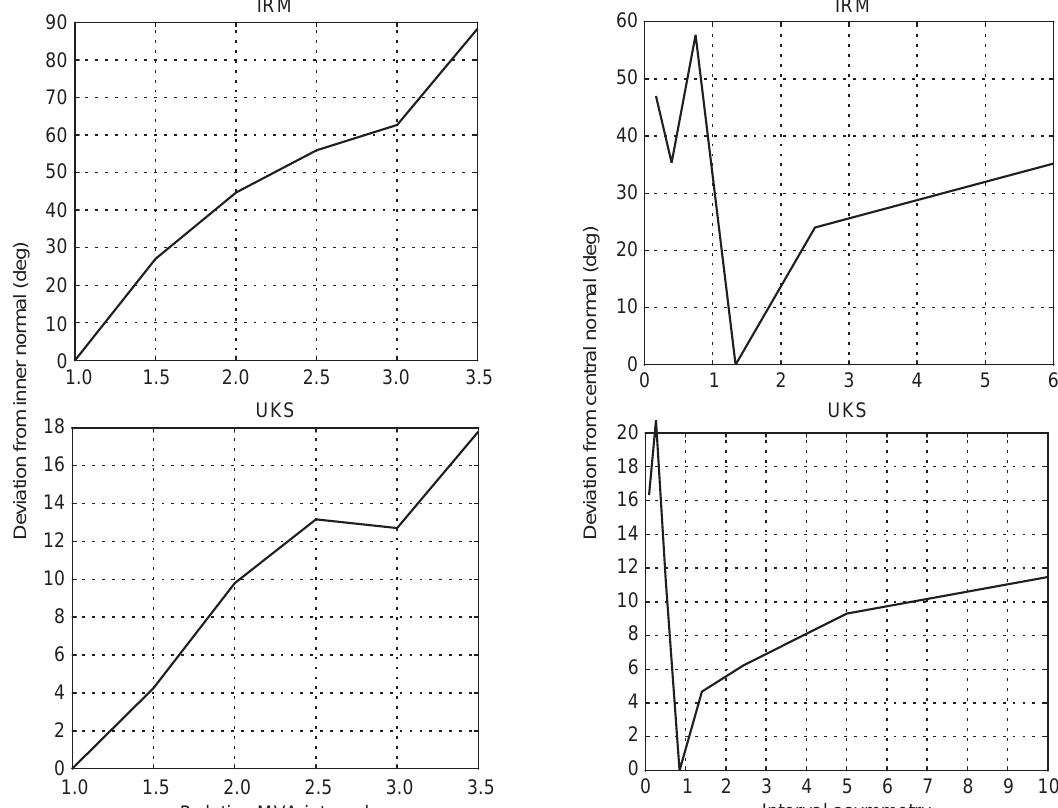
Fig. 9a, b. Sensitivity of MVA analysis to the event shown in Fig. 9., a in terms of nesting and b in terms